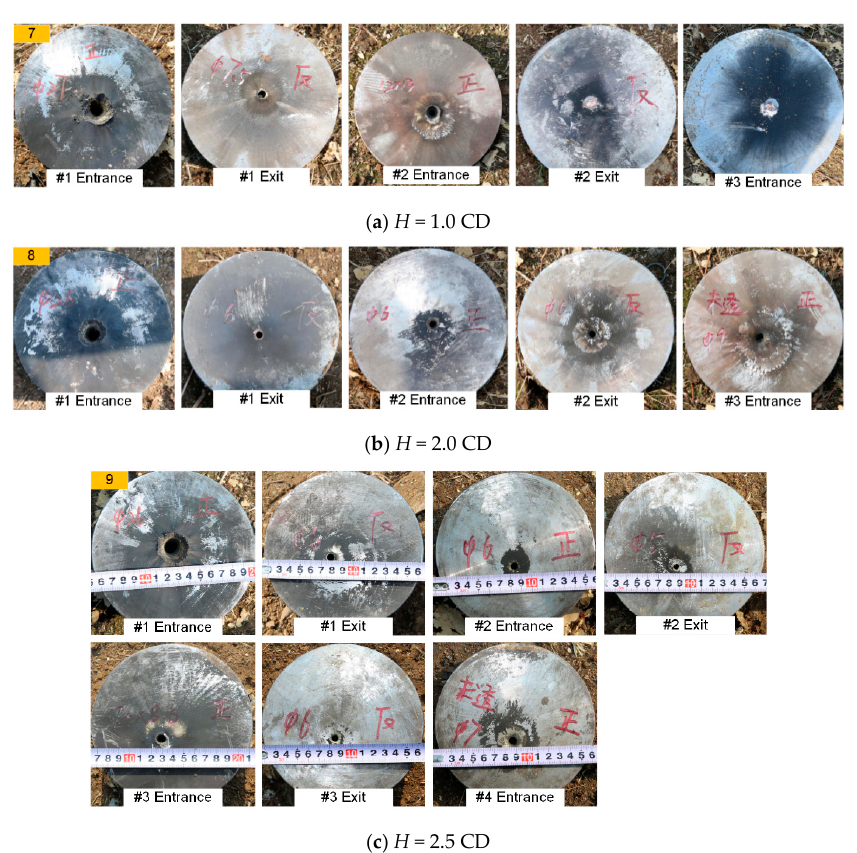
Figure 6. Typical experiments of RM-CL shaped charge with a 4-mm reactive liner.